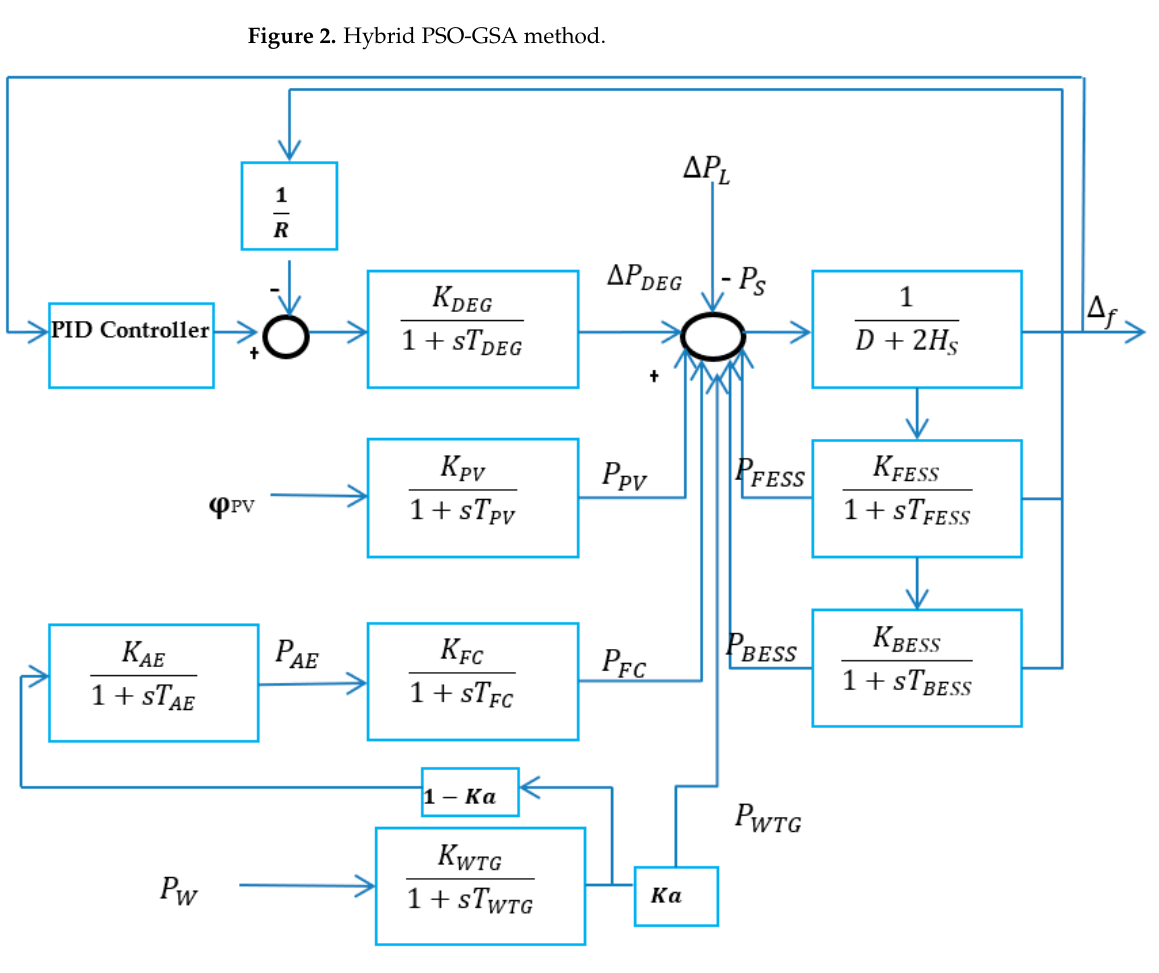
Figure 3. Studied system.